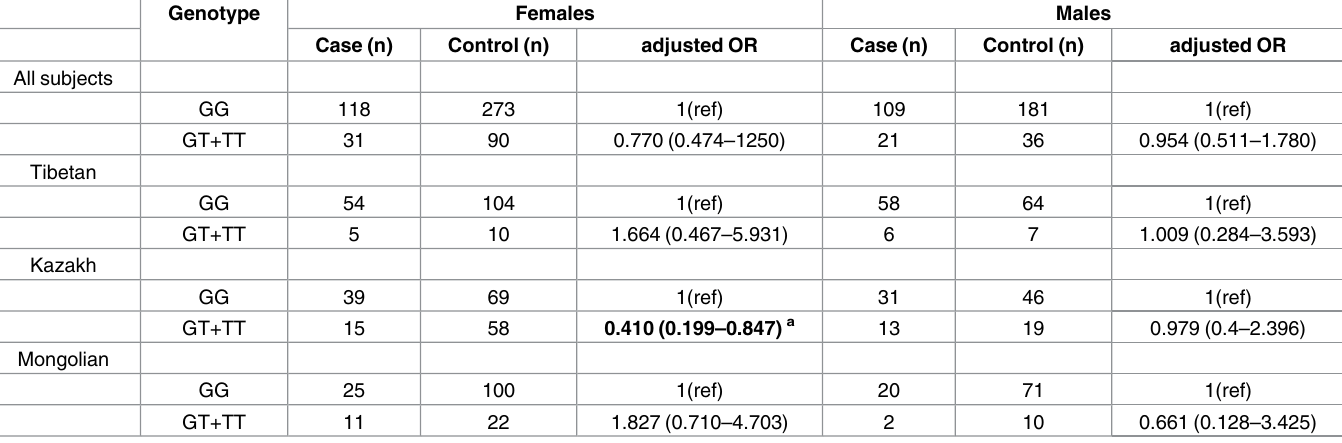
Table 5. Associations between skeletal fluorosis and the PRL rs1341239 genotype in different gender groups (overall or stratified by ethnicity).